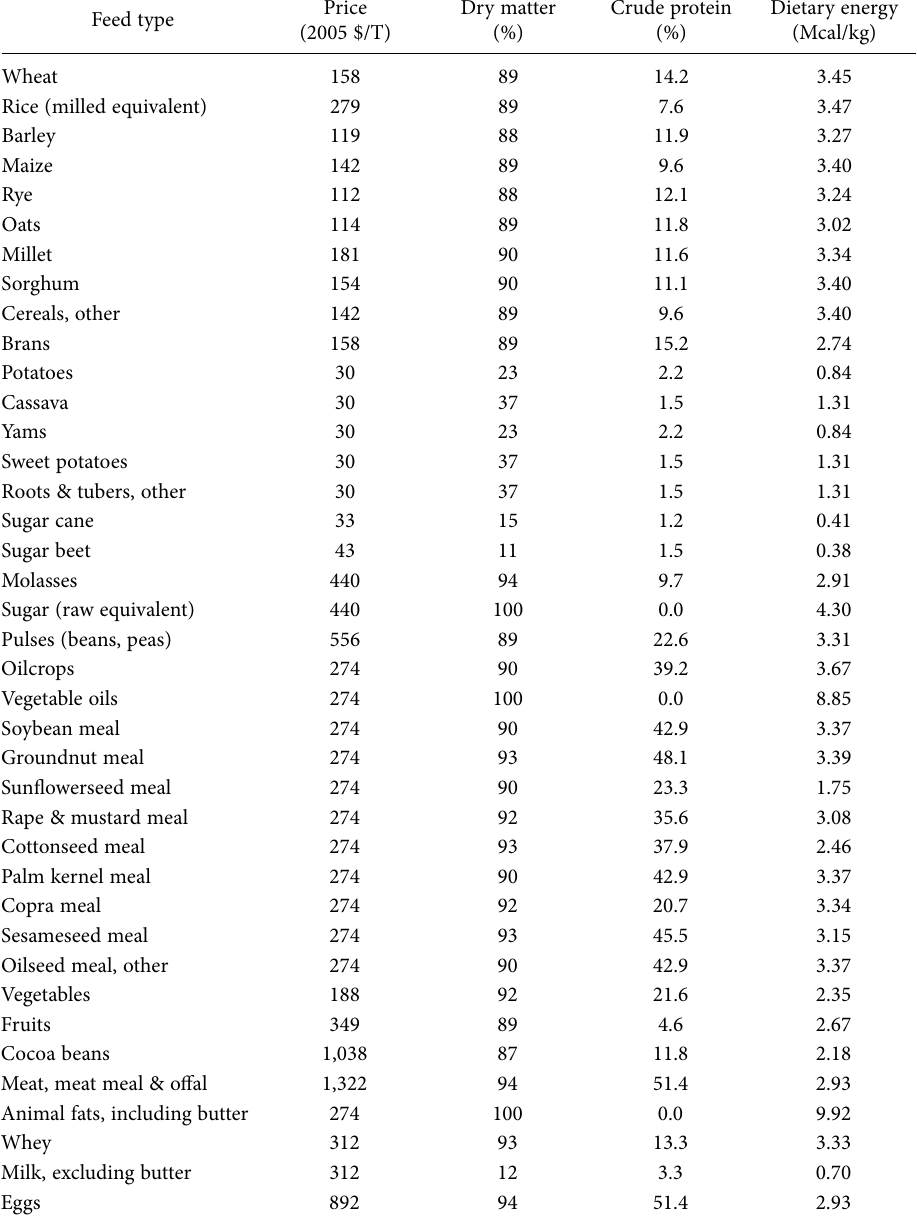
Table A1. Composition and Price of Animal